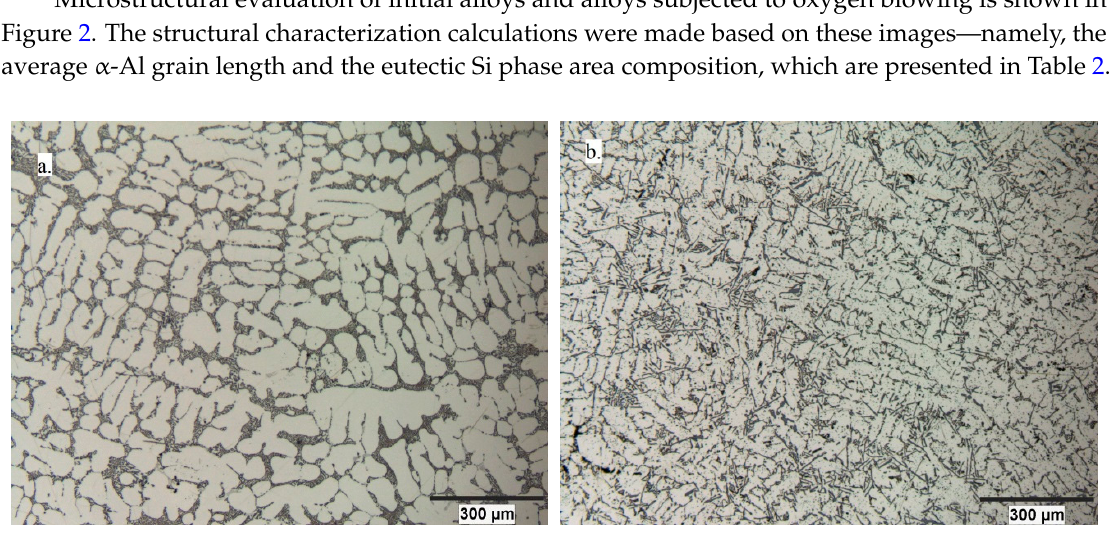
Figure 2. Optical microstructures of the ( a ) initial alloy and ( b ) alloy treated by oxygen blowing. Table 2. Structural characterization of the initial and treated by oxygen blowing alloys. Alloy